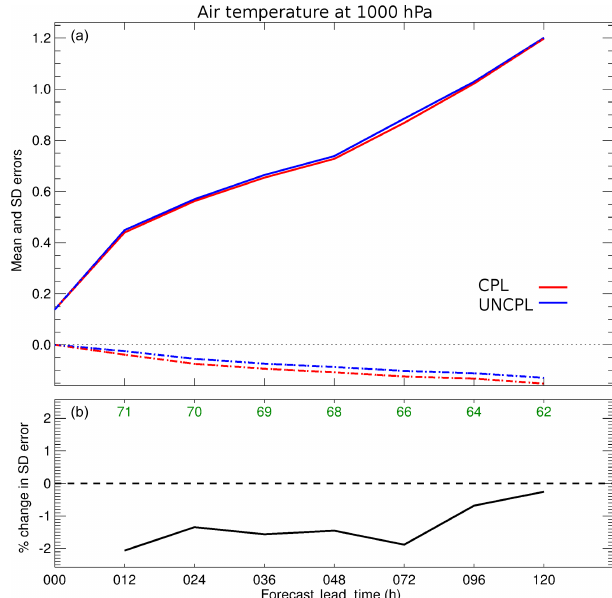
Figure 7. (a) Standard deviation (solid curves) and bias (dashed curves) growth ( ◦ C) as a function of forecast lead time for the air temperature at 1000hPa. The statistics are computed for the CPL (red) and UNCPL (blue) against the mean analysis in the north- ern extratropics region between 20 and 60 ◦ N. (b) The difference in the standard deviation error in percent between CPL and UNCPL. Green indicates the number of samples used to compute the statis-